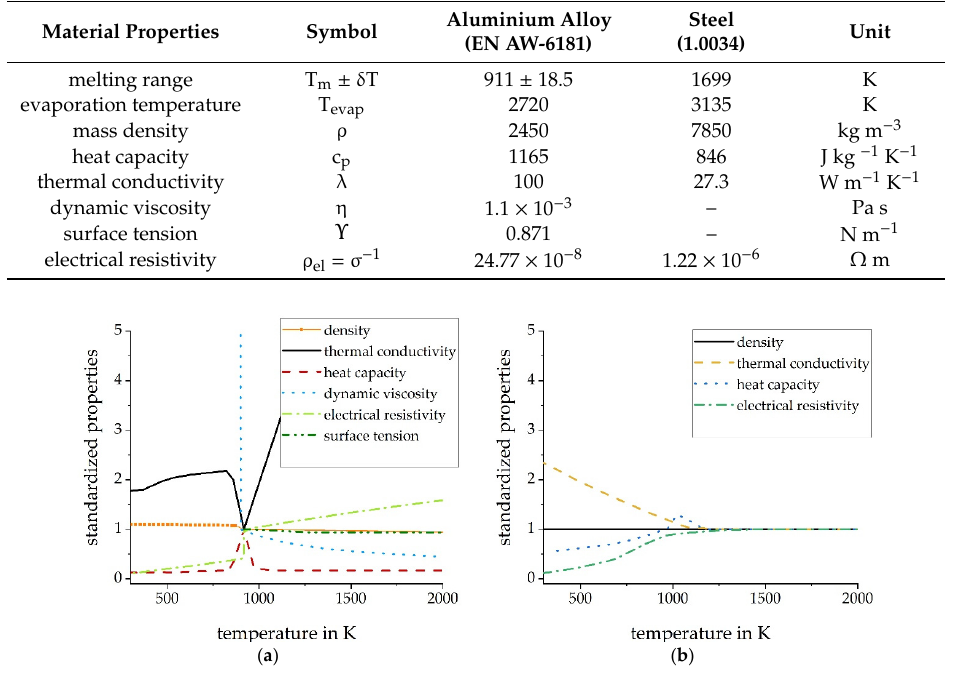
evaporation temperature